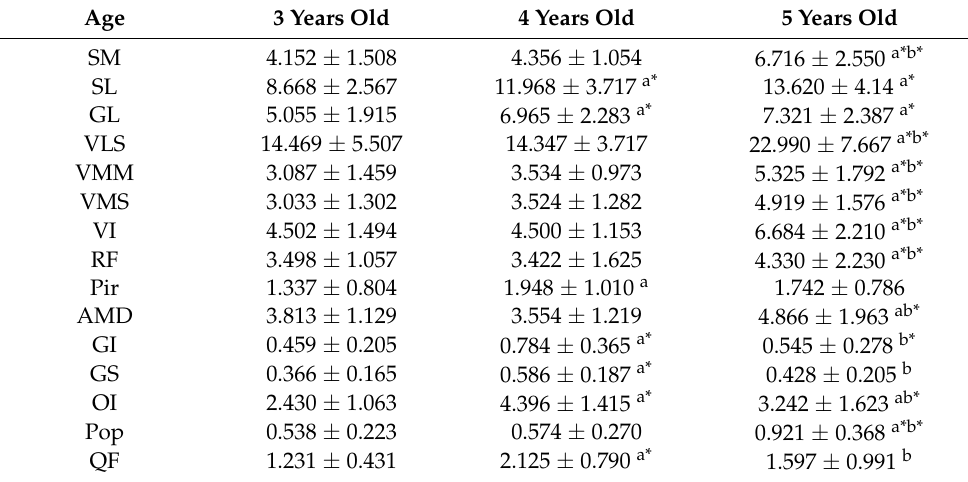
Table 8. Results of age effect of muscle force.